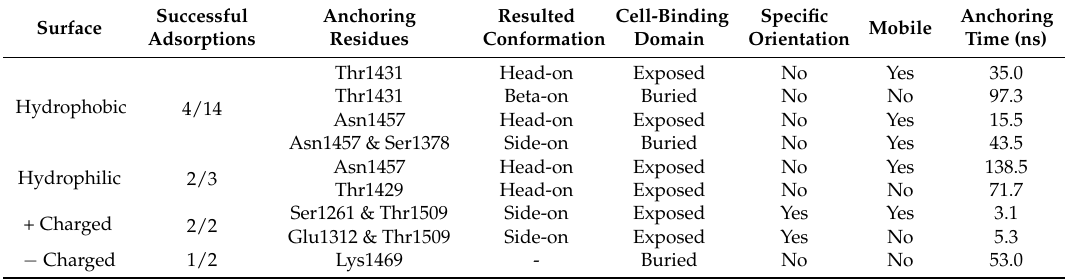
Table 2. Number of successful adsorptions, initial anchoring residues, resulted conformation, availability for cell binding domain after adsorption, specific orientation, mobility after anchoring, and anchoring time on each type of